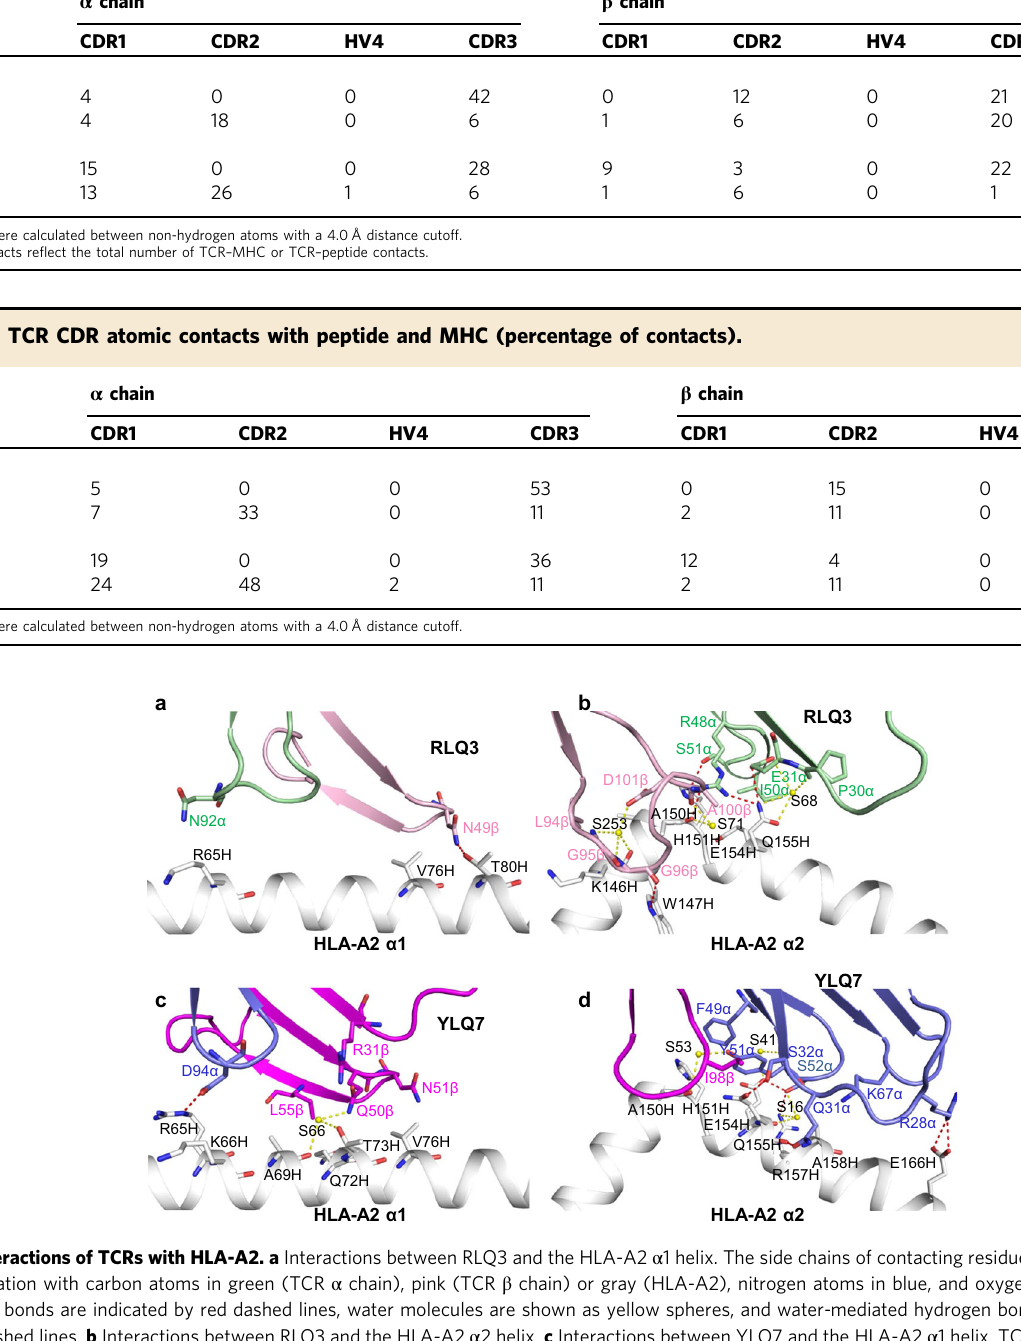
Table 1 TCR CDR atomic contacts with peptide and MHC (number of contacts). α chain β chain